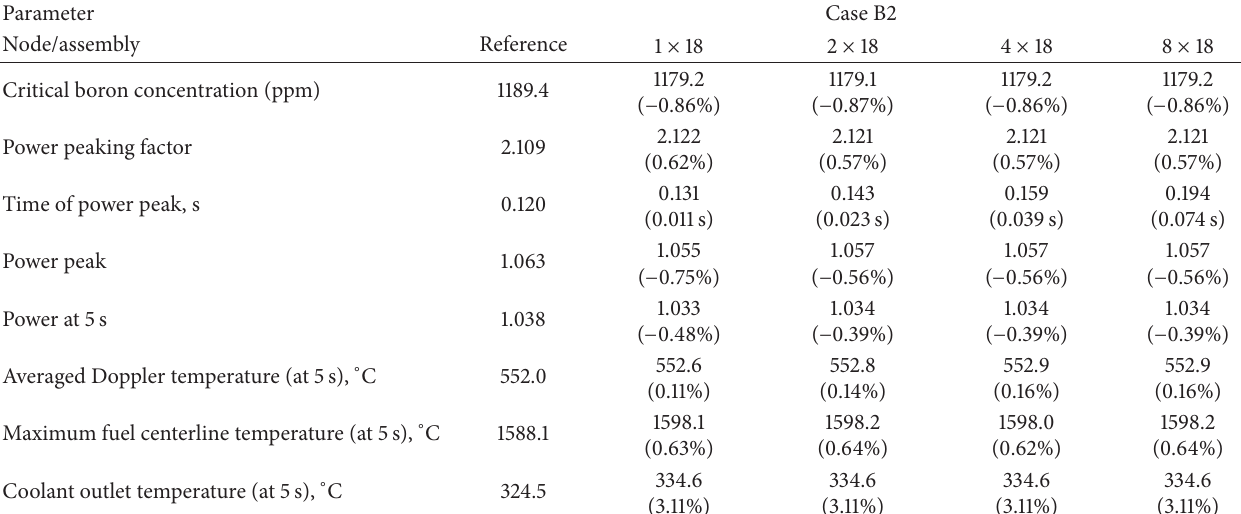
Table 5: Sensitivity analysis results in the axial node number per assembly for case